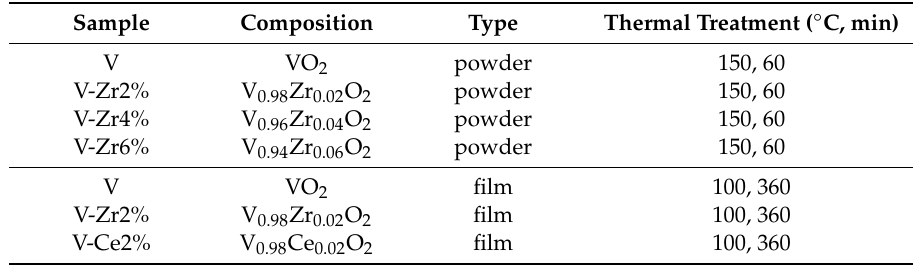
Table 1. Investigated samples. Thermochromic smart window samples denomination; pure vanadia, Zr-doped vanadia, and Ce-doped vanadia. Sample Composition